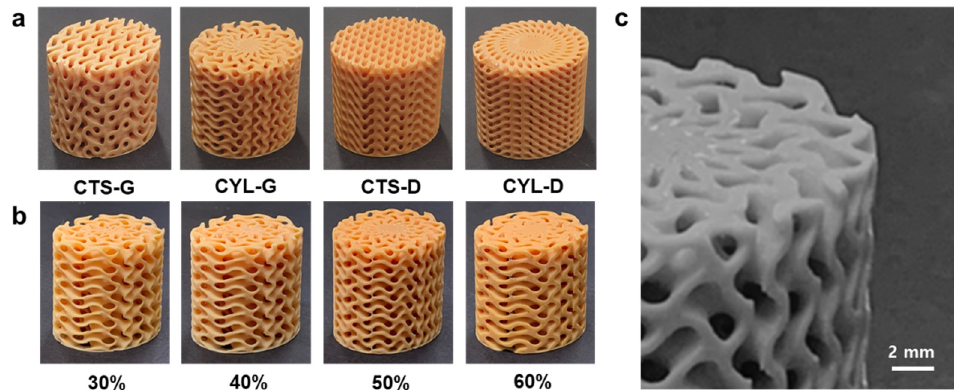
Figure 7. Additively manufactured TPMS structures: ( a ) Various TPMS shapes (50% volume fraction). ( b ) Various volume fractions (CYL-G type TPMS). ( c ) Microscopic image of the TPMS structure (CYL-G type TPMS with 50% volume fraction). Table 4. Comparison for the mass of various TPMS shapes (volume fraction: 50%).